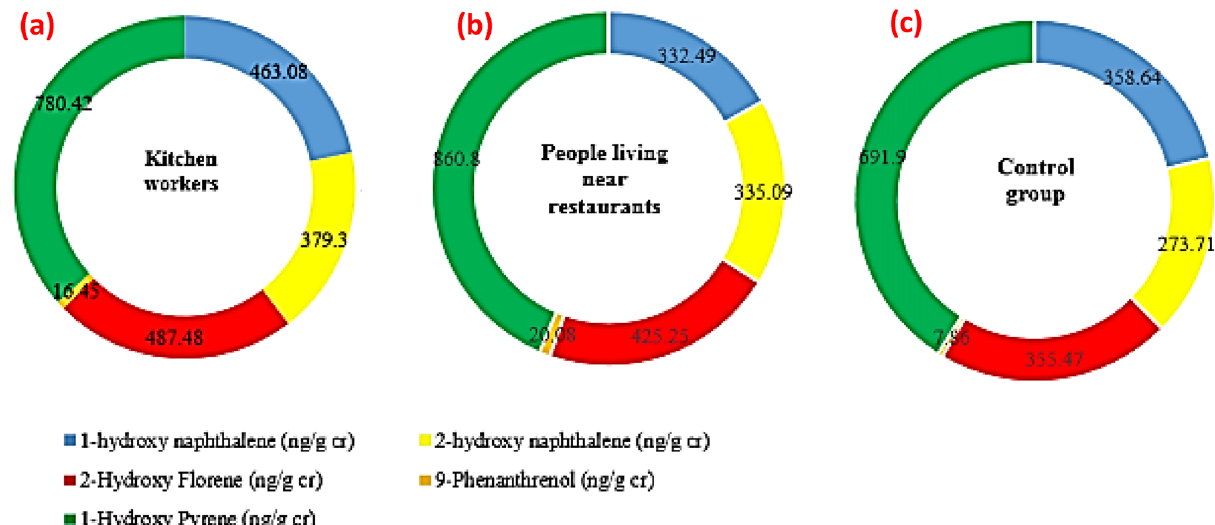
Figure 1. Mean levels of OH-PAH metabolites in the studied group’s urine samples (ng/g cr) (( a ) kitchen workers, ( b ) people living near restaurants, and ( c ) the control